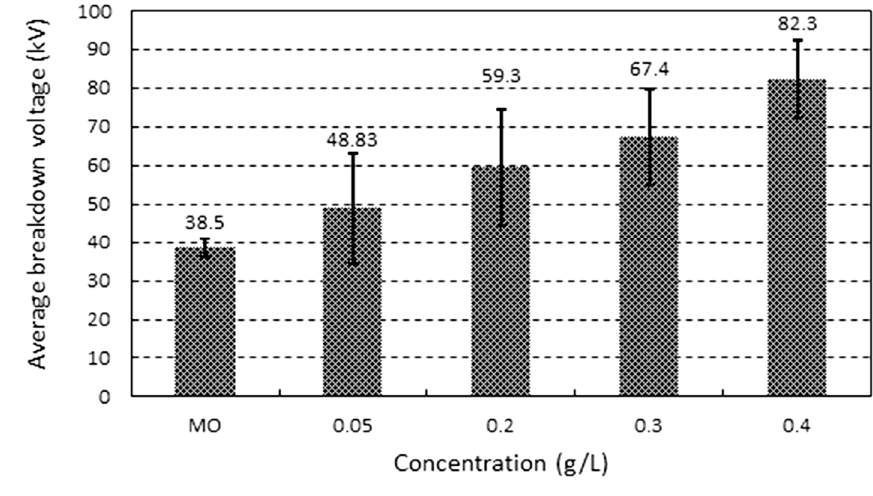
Figure 7. The breakdown voltages of MO/Fe 3 O 4 NFs.